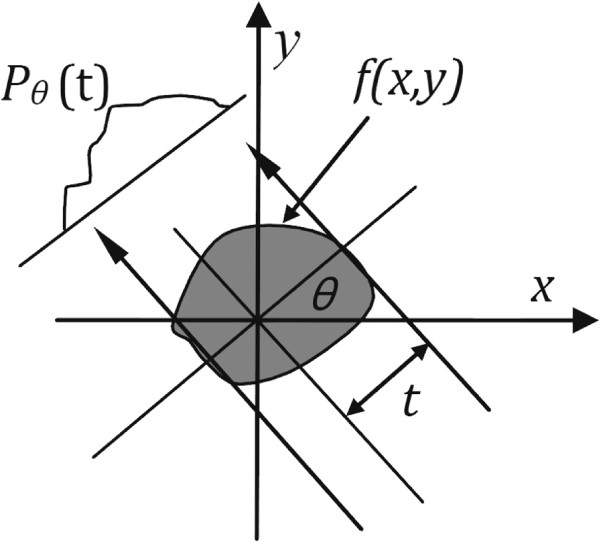
Parallel Projection: an objectf(x,y) and its projectionPθ(t) are shown from the angleθ.